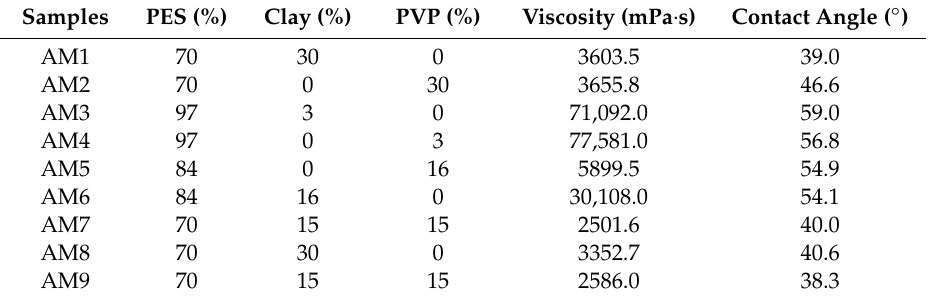
Table 2. Viscosity and contact angle results according to the experimental design